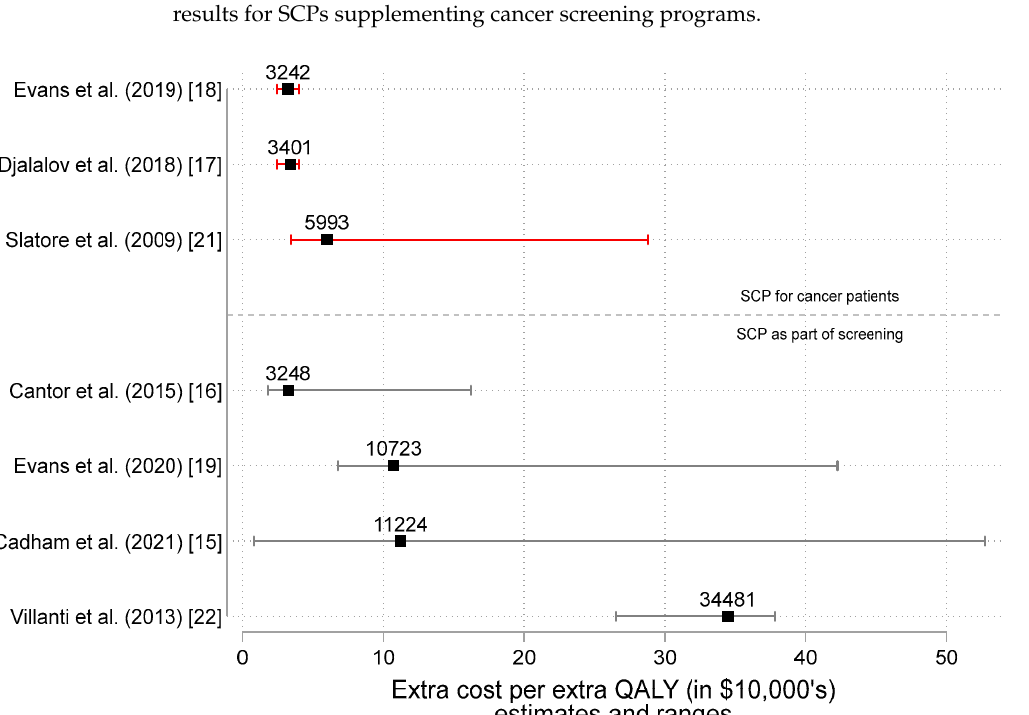
) show study (cid:35)